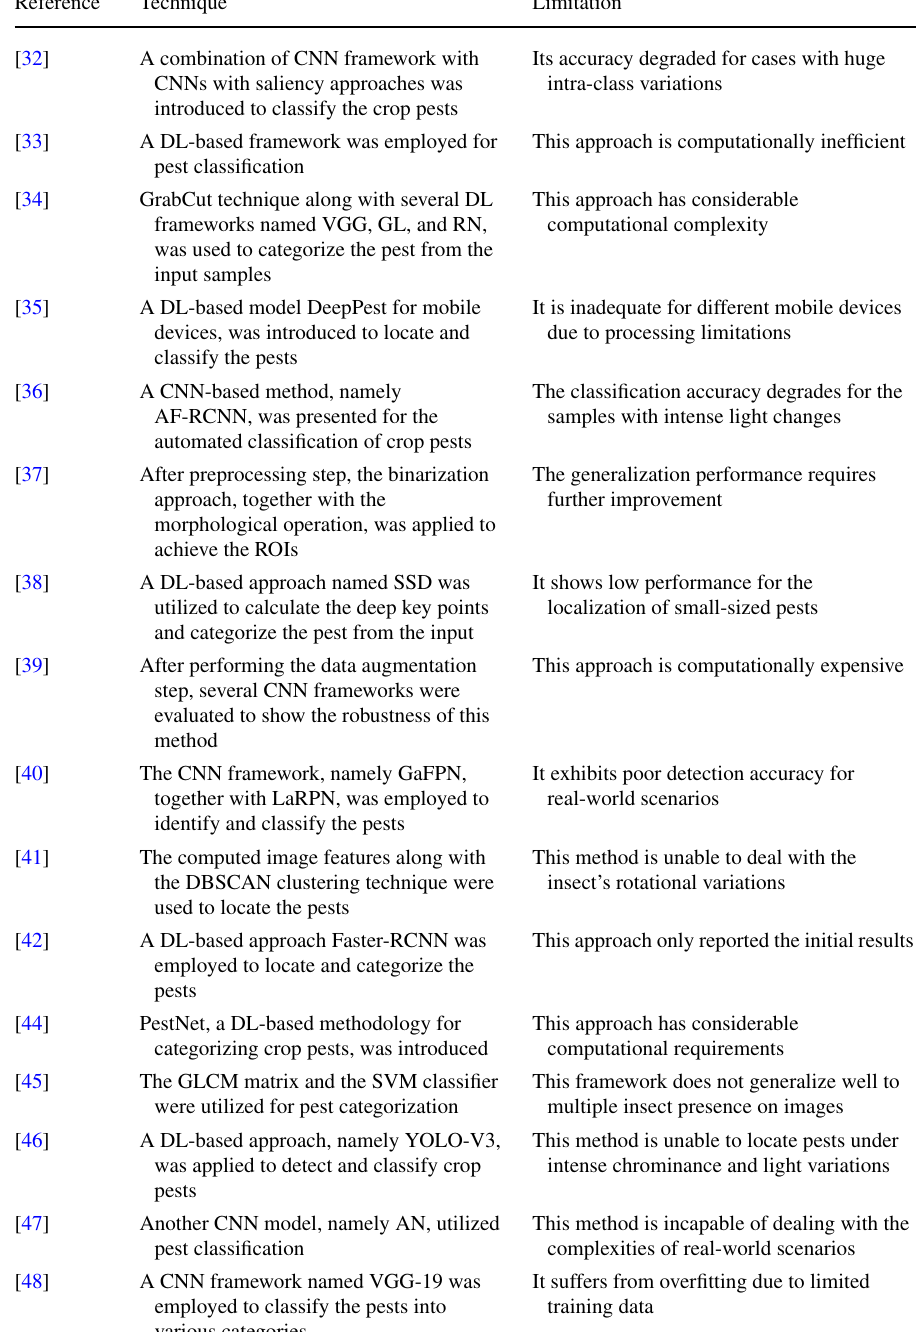
Table 1 Comparative analysis of existing pest detection techniques